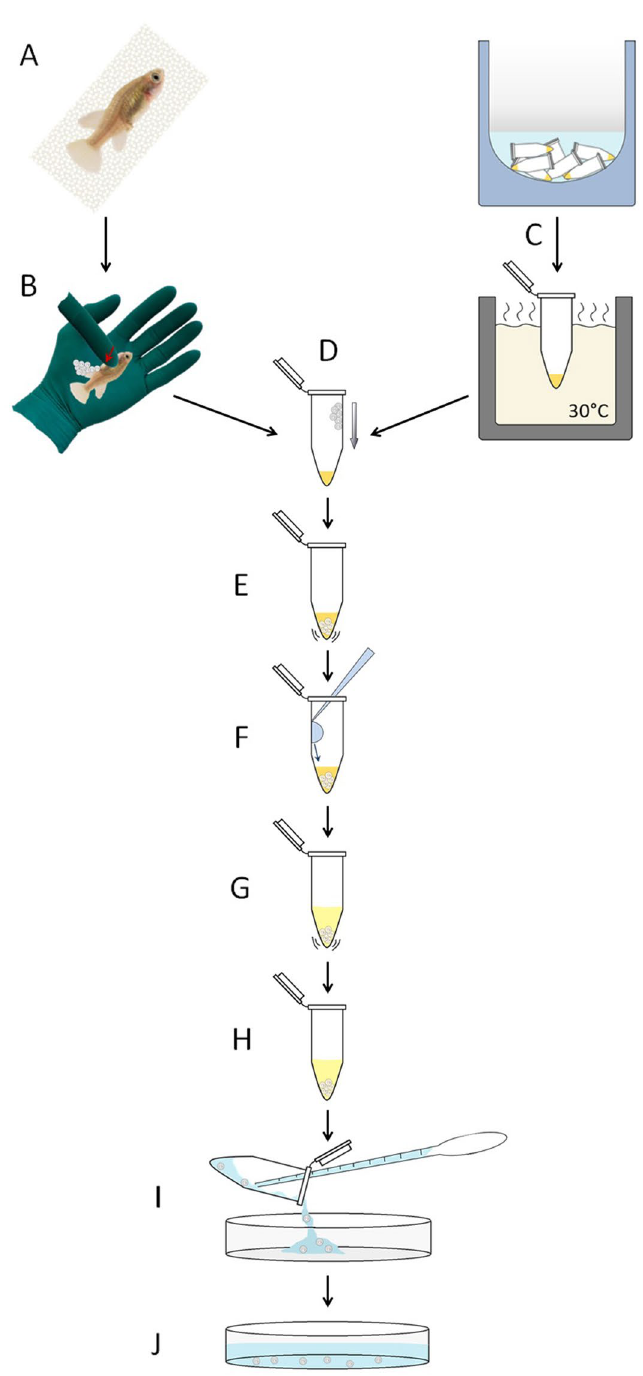
Figure 5. Schematic of sperm thawing and egg fertilization procedure. ( A ) Female preparation. ( B ) Egg collection through gentle abdominal squeezing. ( C ) Frozen sperm thawing in a water bath. ( D , E ) Eggs mixed with sperm-extender solution. ( F ) Activating solution addition and ( G ) mix. ( H ) Fertilization. ( I ) Egg recovery in a petri dish. ( J ) Fertilized eggs developing in a petri dish. For detailed explanation, refer to the protocol in S1 file and “Materials and